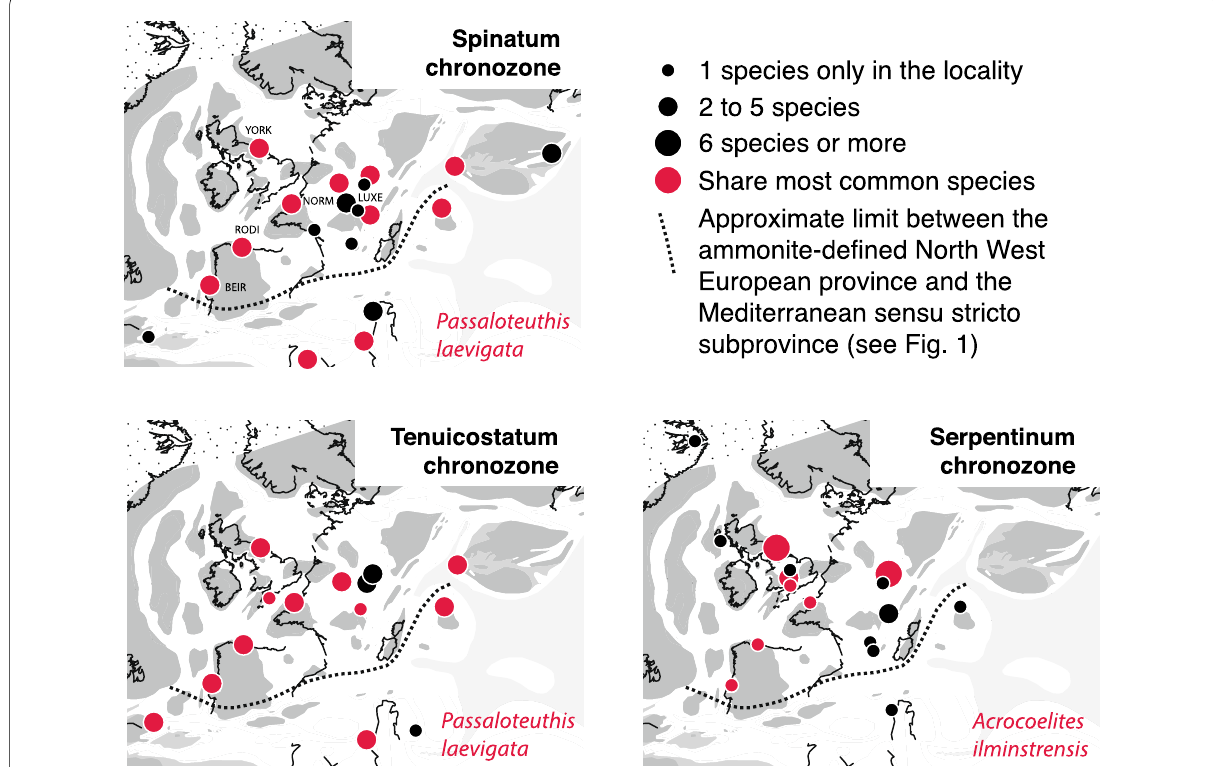
Fig. 1 Paleogeographical distribution of belemnite occurrences during the Spinatum, Tenuicostatum and Serpentinum Zones. The localities yielding the most reported species are marked in red ( modified from Neige et al., 2021). Note that the Lusitanian basin is herein assigned to the edge of Euro‑boreal realm (NW‑European domain), but in some analyses it belongs to the Mediterranean realm (Mediterranean domain) during the early Toarcian (Dera et al.,